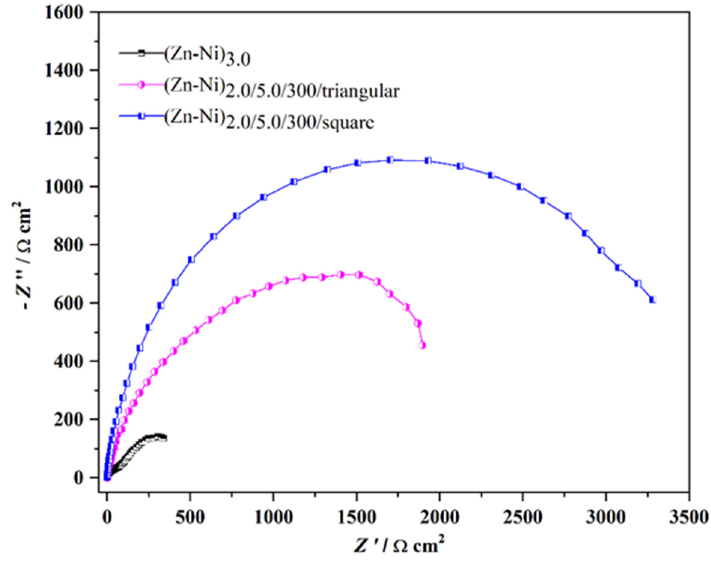
Figure 5. Electrochemical impedance spectra of single-layer and multilayer coatings.